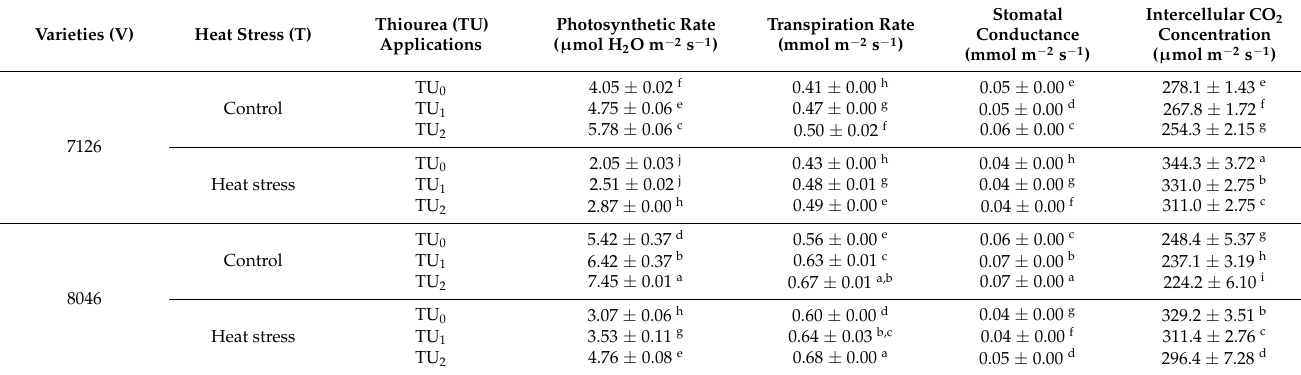
Table 2. Impact of thiourea priming and heat stress on gas exchange attributes of two camelina varieties. Varieties